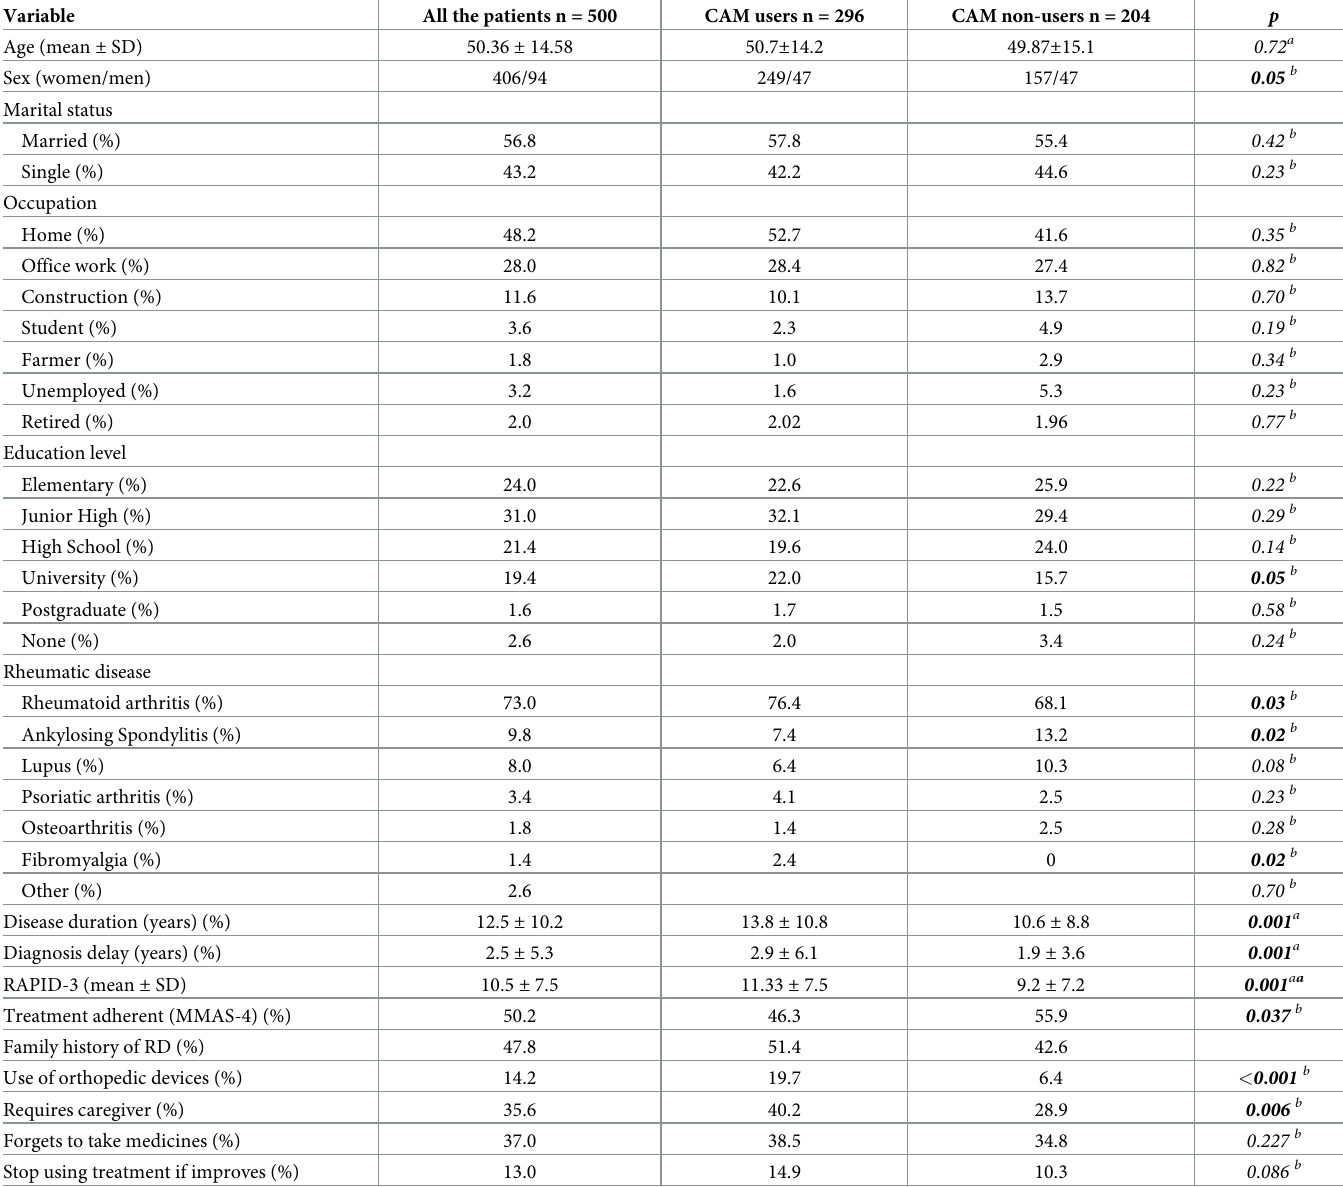
Table 1. Sociodemographic